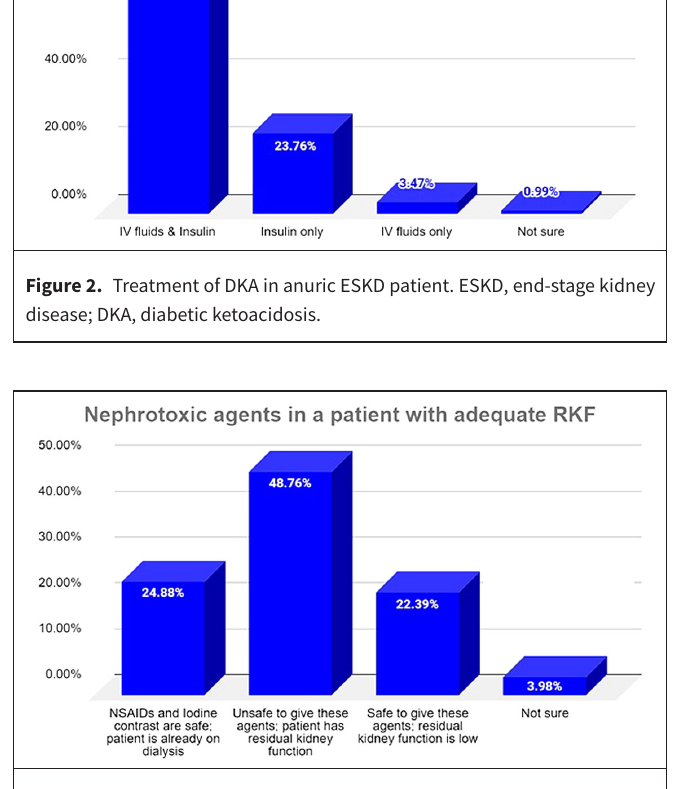
Figure 3. Nephrotoxic agents in a patient with adequate RKF. RKF, residual kidney function.